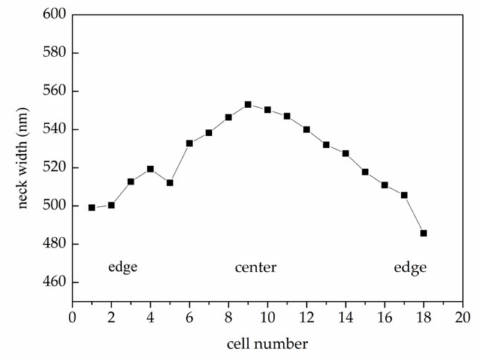
Figure 3. The neck width of the tip post at different positions.